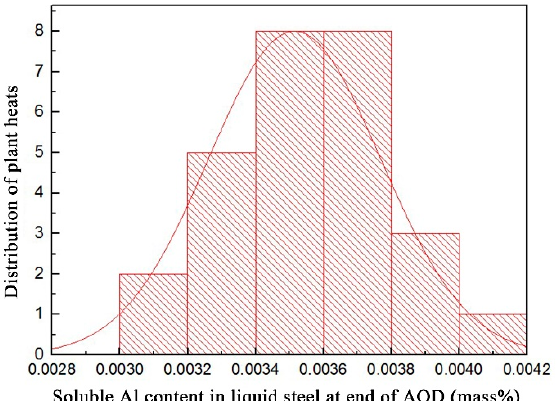
Figure 17. Content of soluble Al content in liquid steel at the end of AOD. Table 11. The liquid steel composition before and after the process optimization (mass%).